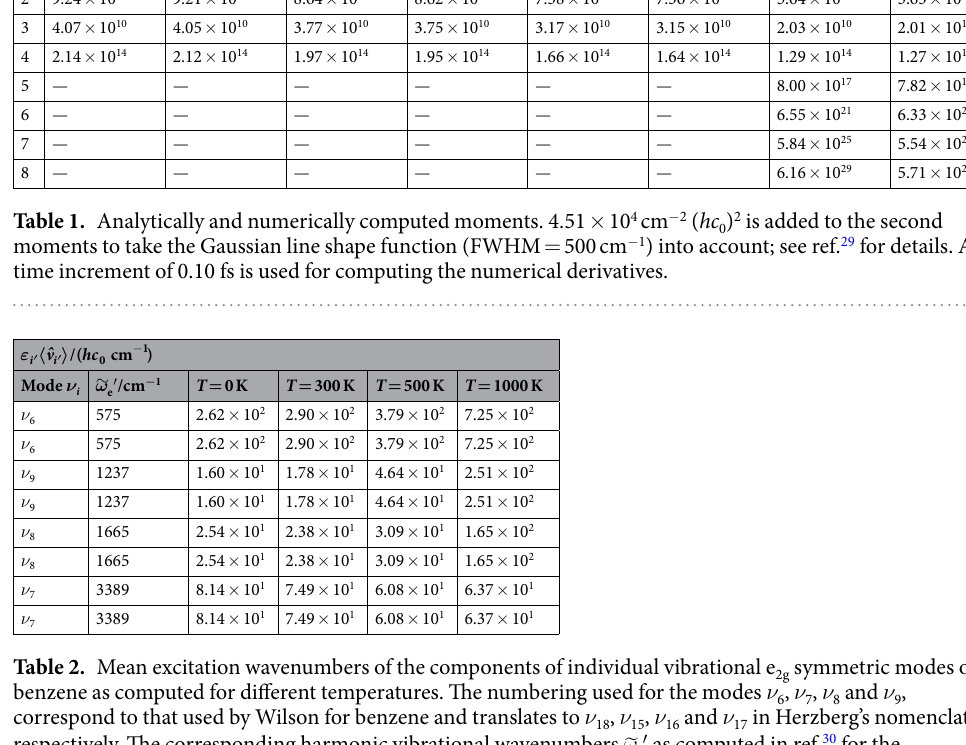
a given time increment determines the desired spectral resolution and the total wavepacket propagation time. Herein we compared a numerical approach for the calculation of cumulants with the results from an analyti- cal scheme. The results obtained numerically are still fairly good. With this method, one can incorporate easily nonlinear non-Condon terms and various line shape functions. In the time-correlation function calculation the real part and imaginary part at each time step provide automatically the even and odd moments, respectively. In the first few time steps we already have the first few moments available and the probability distribution function (information) becomes complete as time progresses. The benzene example selected herein serves to illustrate the principle of the method for future routine applications for molecular systems with hundreds of atoms. As an outlook for the approach described herein, we would like to indicate that it can be generalized for the even more challenging anharmonic vibronic transition problem, because the method has a clear connection to the time correlation function approach. When the time correlation function can be evaluated only for the first few time steps, the cumulants can be determined numerically. The overall computational cost is only the evaluation of a few time correlation function.